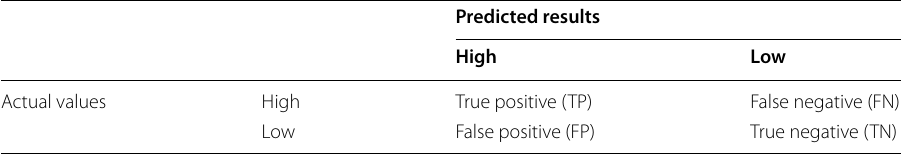
Table 5 A confusion matrix for binary classification model